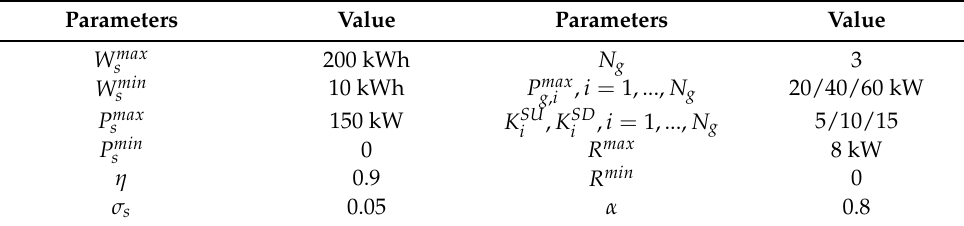
Table 1. Values of the